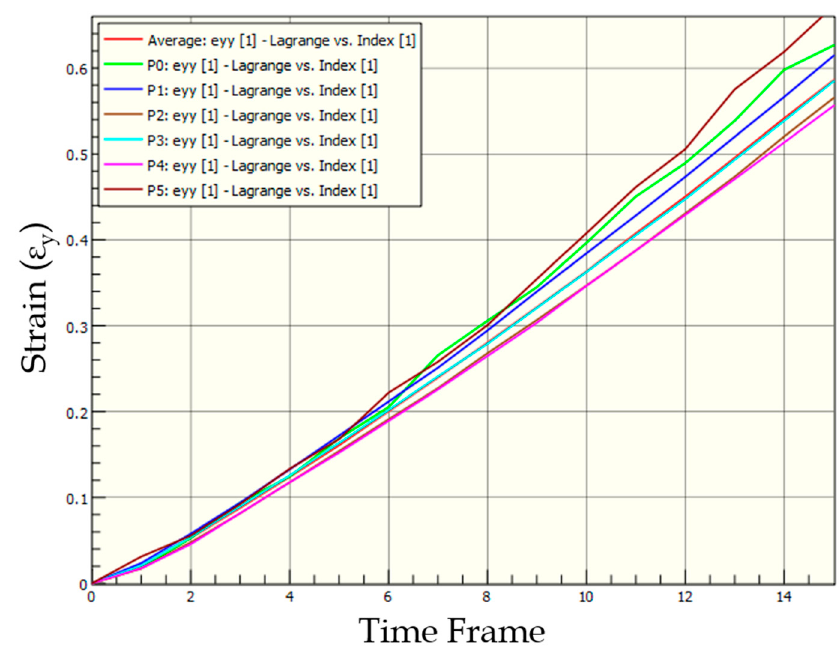
Figure 7. Strain (y ‐ axis) versus time frame (x ‐ axis) measured using DIC from tensile test on the Figure 7. Strain (y-axis) versus time frame (x-axis) measured using DIC from tensile test on the biofidelic human skin specimen with no wound. biofidelic human skin specimen with no